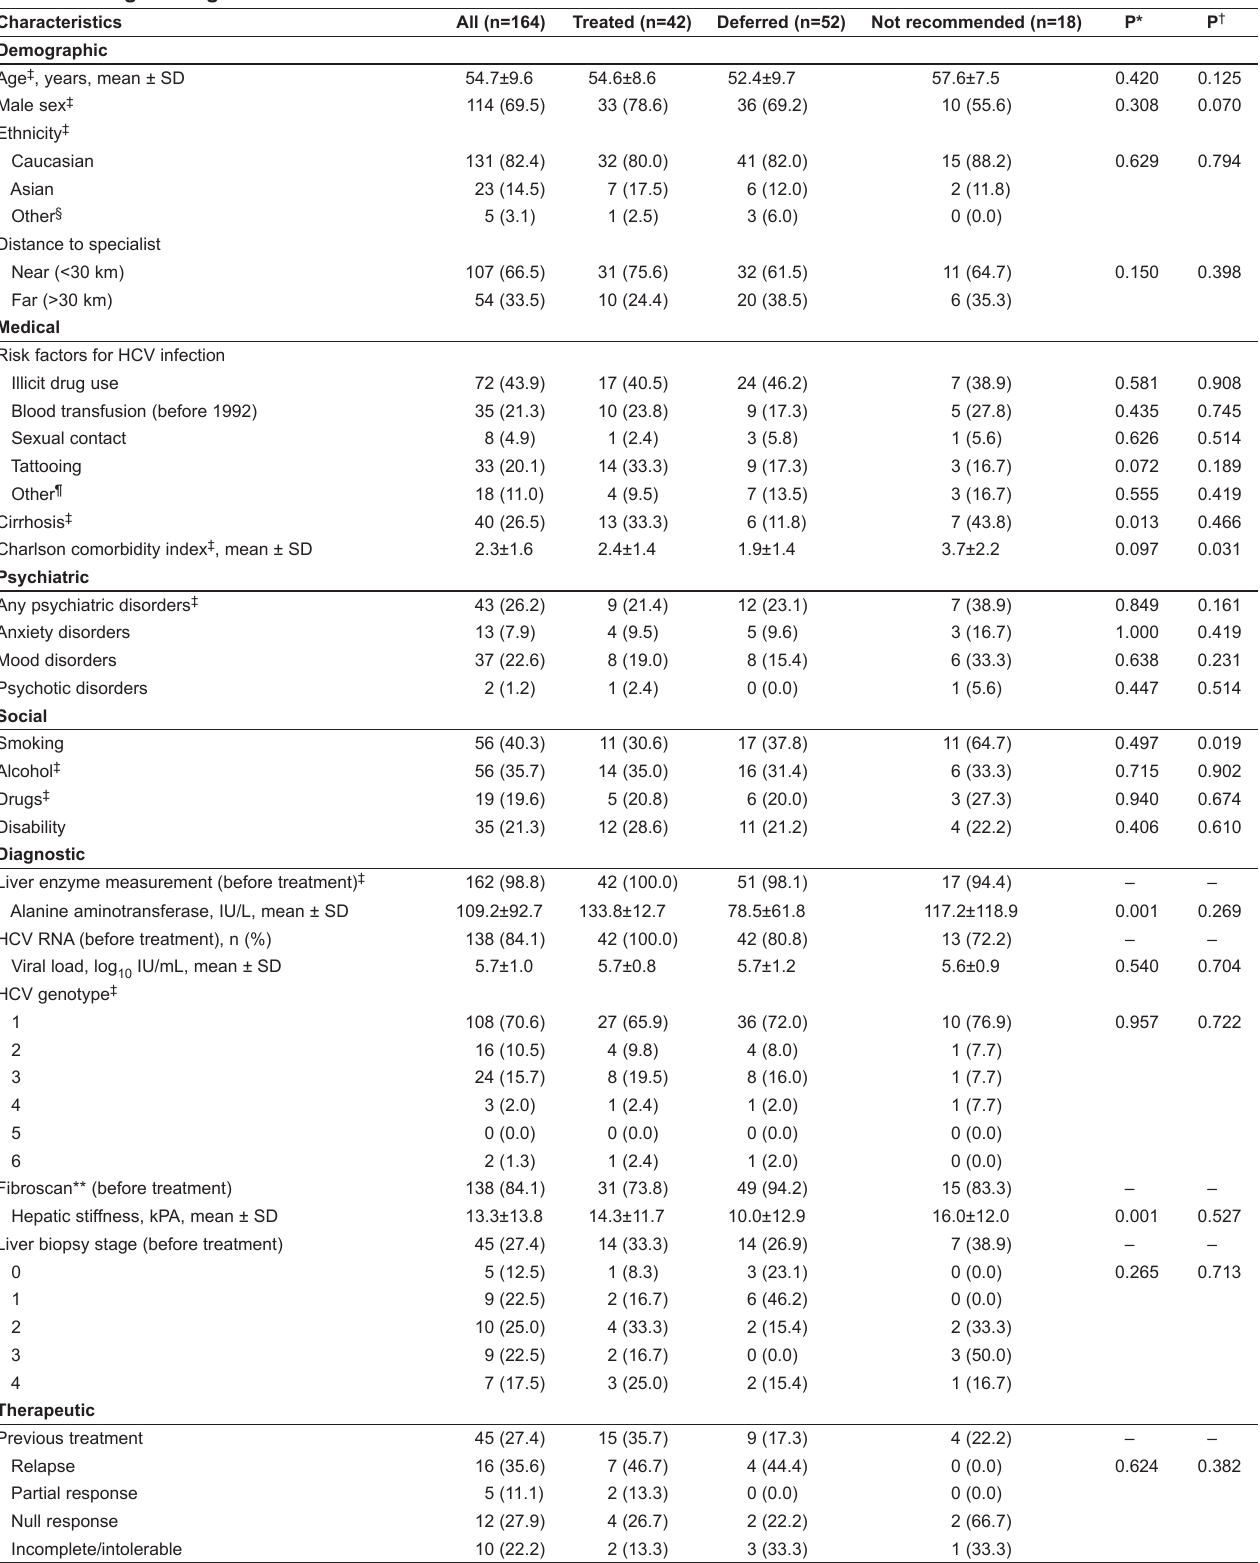
Table 1 Univariate logistic regression for treatment initiation